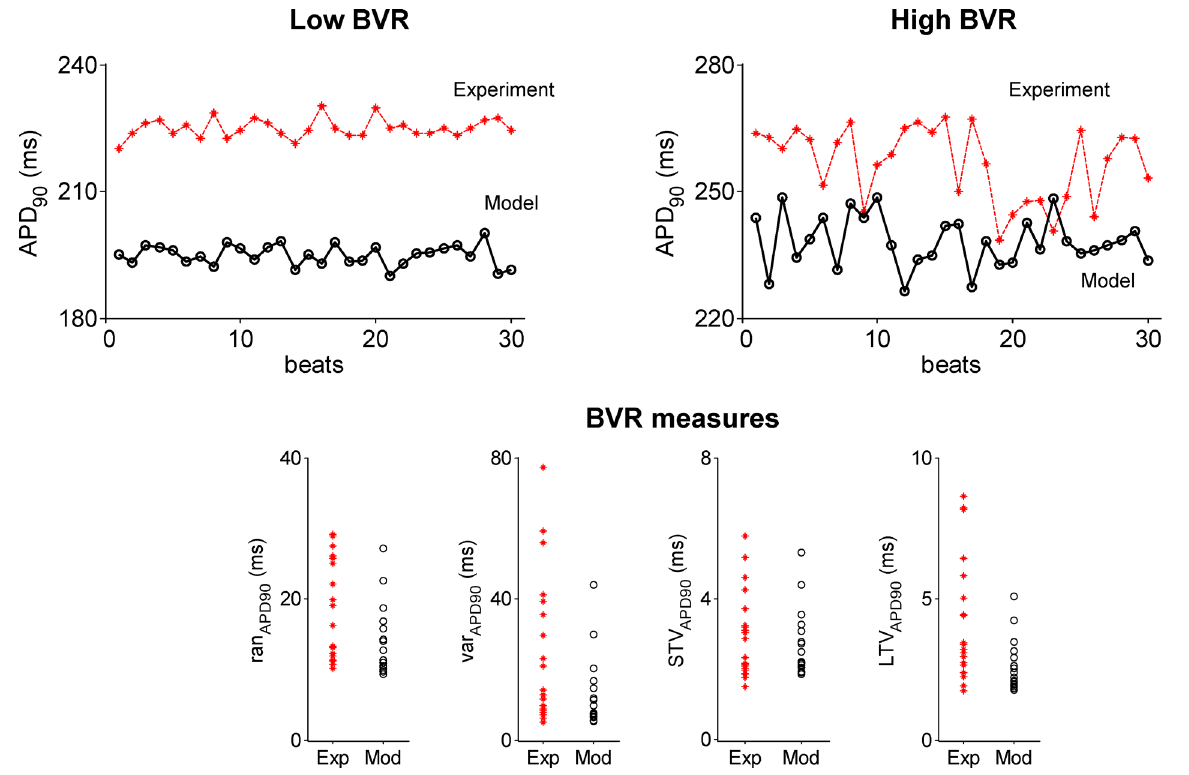
Fig 4. Results from population of stochastic models under control conditions. Top: APD sequences of 30 beats for individual experiments and model realizations under control, illustrating cases associated with low (left) and high (right) temporal variability. Bottom: BVR measures in experiments (red crosses) and simulations (black open circles), calculated in mean over realizations, under control conditions. The BVR measures, from left to right, are as follows: ran APD , var APD , STV APD and LTV APD